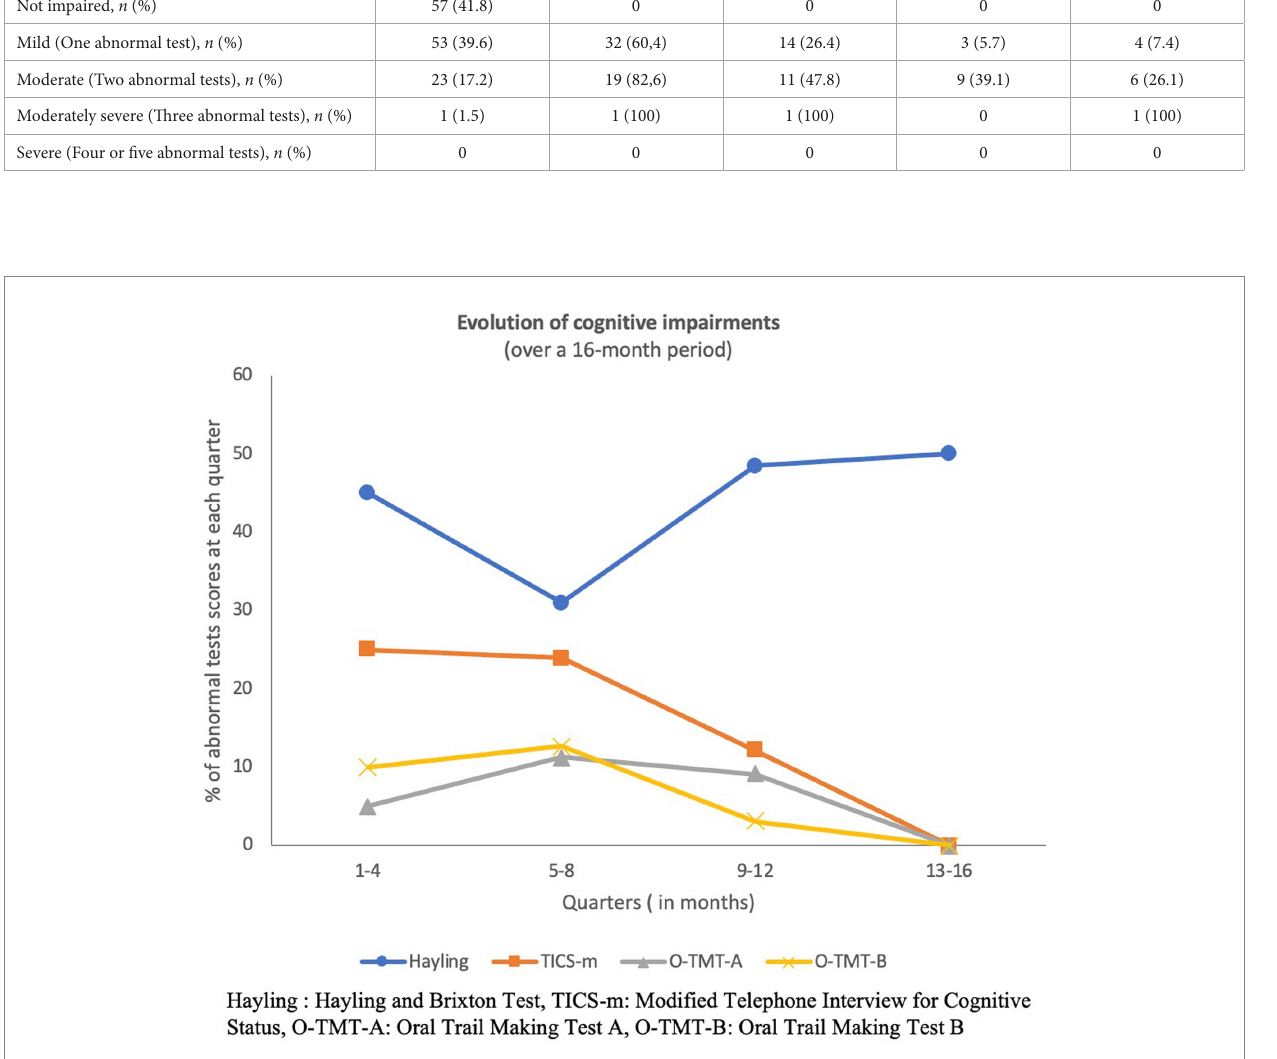
FIGURE 3 Cross-sectional evolution of cognitive impairments throughout the study